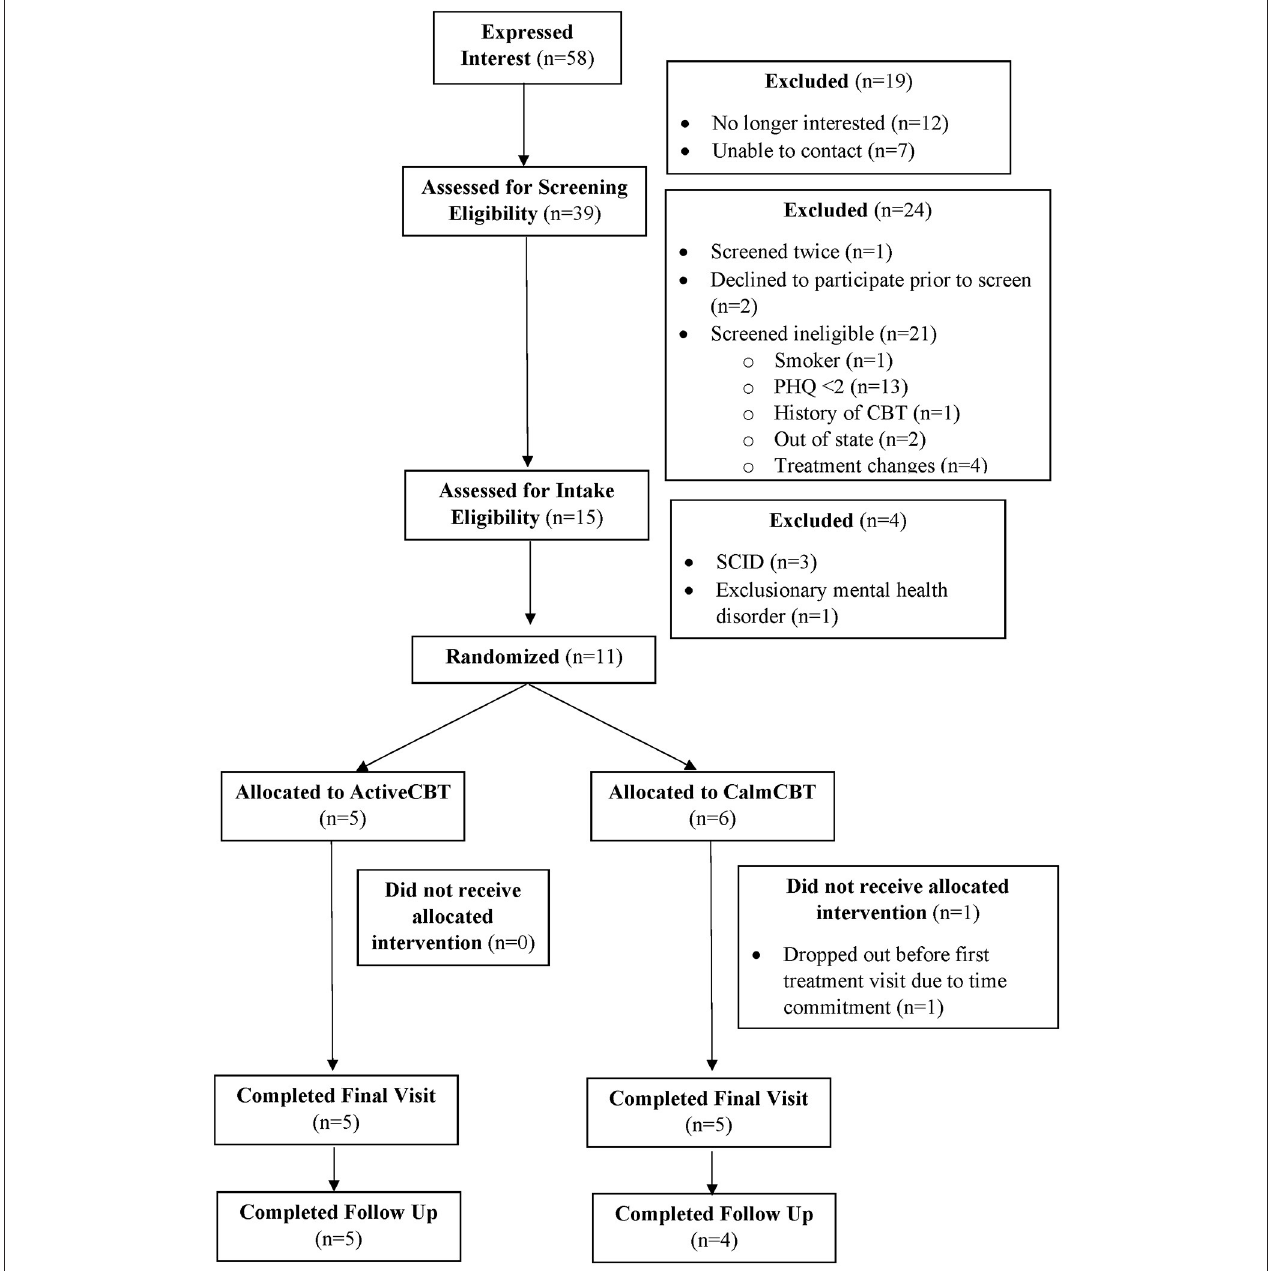
FIGURE 1 | CONSORT diagram. PHQ, Patient Health Questionnaire; CBT, Cognitive Behavioral Therapy; SCID, Structured Clinical Interview for Depression.